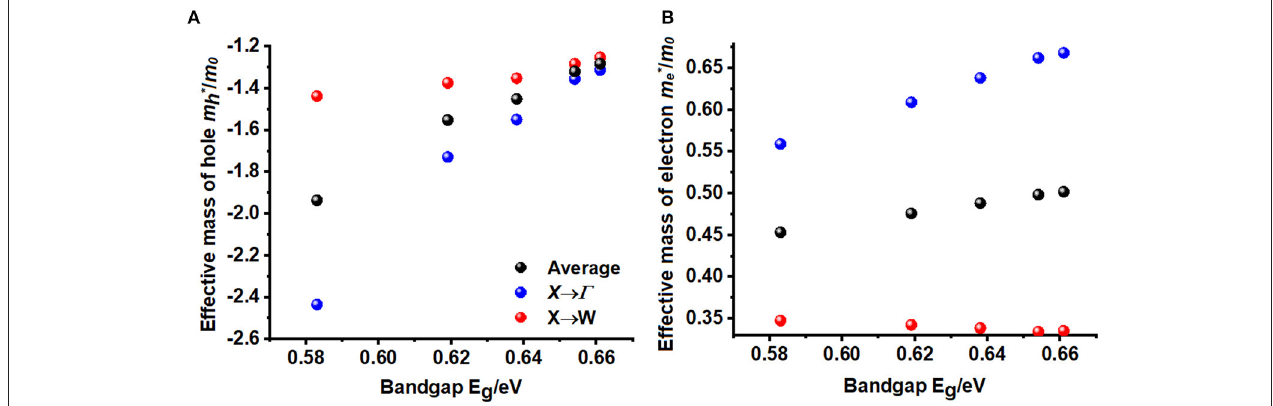
FIGURE 3 | Dependence of non-spin polarized effective mass of (A) holes and (B) electrons holes on the bandgap E g for A 2 AgRhCl 6 (A